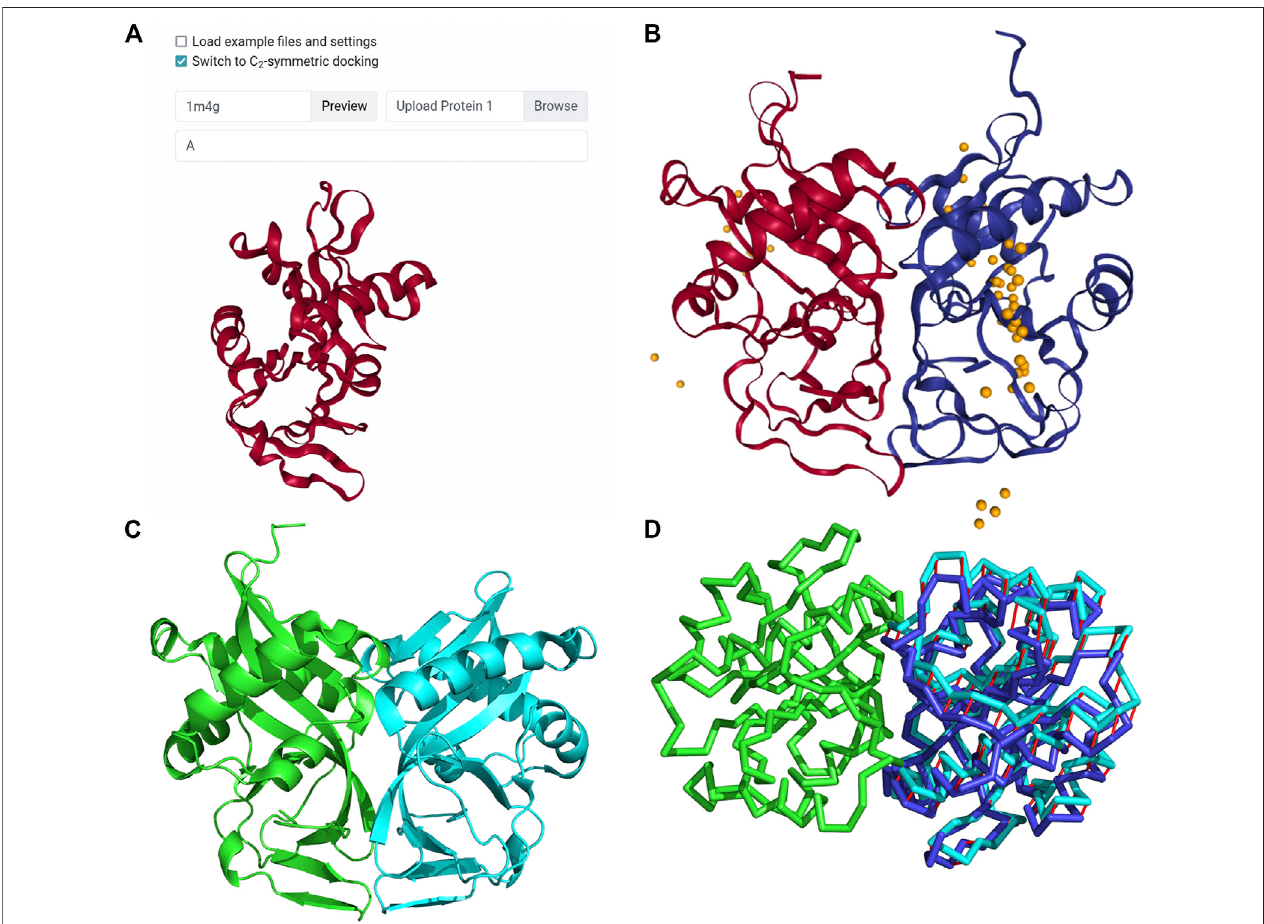
FIGURE 4 | Input and results for C 2 symmetrical docking of bacterial AAC (2 ′ ). (A) The input for symmetrical LZerD. The subunit was uploaded by specifying the PDB ID 1M4G in the input fi eld to fetch the structure from the PDB. A single chain is extracted from this structure by specifying “ A ” in the chain ID selection fi eld. (B) The results of C 2 symmetrical docking. The receptor and ligand are shown in red and blue respectively in the top-1 model conformation and are of course structurally identical. This model has an f nat of 0.88, an I-RMSD of 0.95 Å, and an L-RMSD of 1.9 Å. The distribution of the top 50 ligand centroids is indicated by the orange spheres. All output models satisfy the 5.0 Å symmetricalness criterion. (C) the native structure of this complex, both chains of PDB 1M4G. Note that some N-terminal residuesofchainB(cyan)arenotresolvedrelativetochainA(green).Infact,consideringallcommonatomsbetweenthetwonativechains,theydifferby0.8 ÅRMSD. (D) Visualization of the symmetricalness criterion ’ s satisfaction in the top-1 model viewed along the C 2 symmetry axis. The subunits are shown here in C α trace representation. Green: the receptor; cyan: the correct ligand conformation; blue: the top-1 ligand conformation; red: the deviations of the ligand from the correct conformation. This model satis fi es the symmetricalness criterion with an RMSD of 2.2